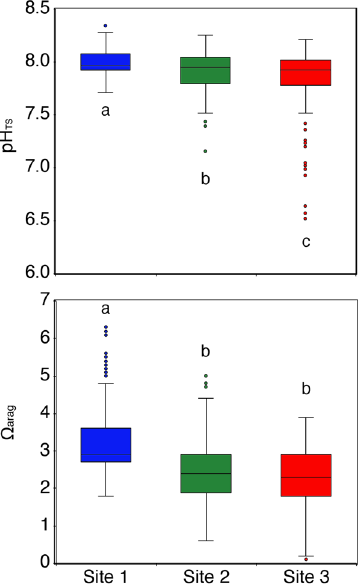
Fig. 1 Ranges of measured pH TS and Ω arag values showing consistent decreases from Site 1 to Site 3. The boxes indicate the 25 th and 75 th percentiles and the line within the boxes mark the medians. Whisker length is equal to 1.5 × interquartile range (IQR). Circles represent outliers. Different letters indicate statistical differences ( p < 0.05; number